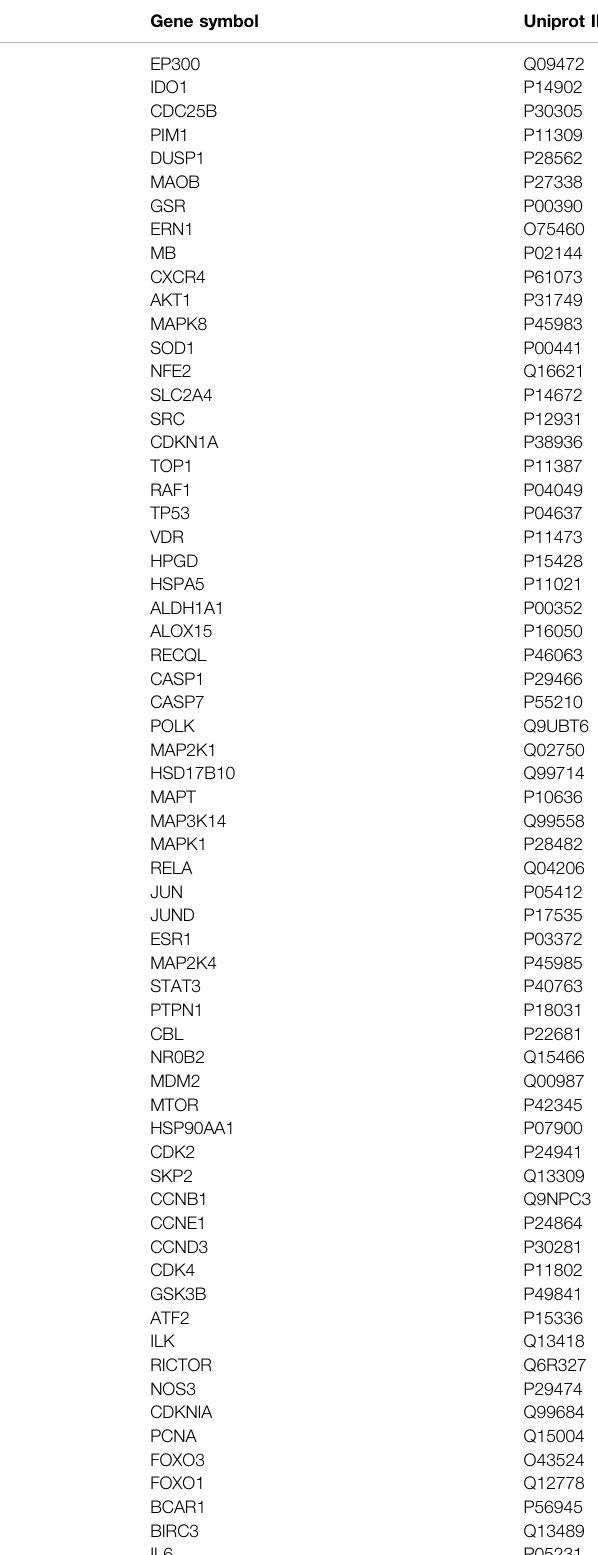
TABLE 1 | Common targets between PL and